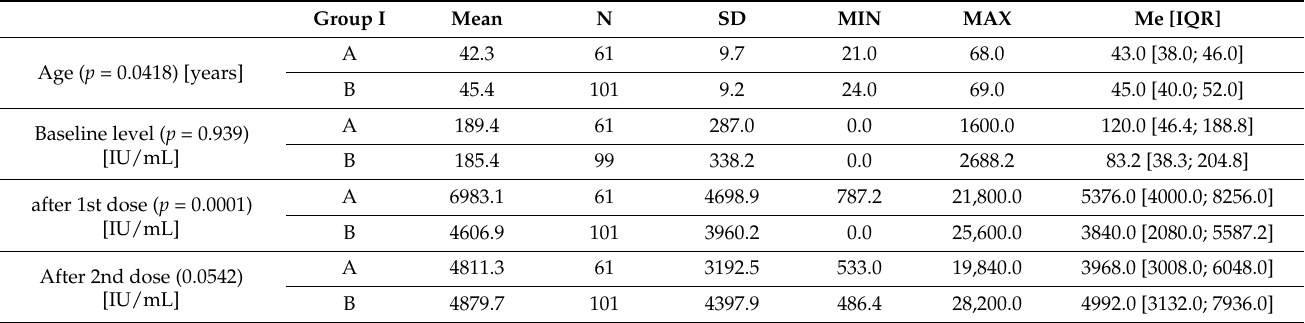
Table 4. Comparison of two subgroups from group I—patients who presented lower antibodies level after second dose of vaccine (A) vs. patients who presented constant increase of antibodies level (B).